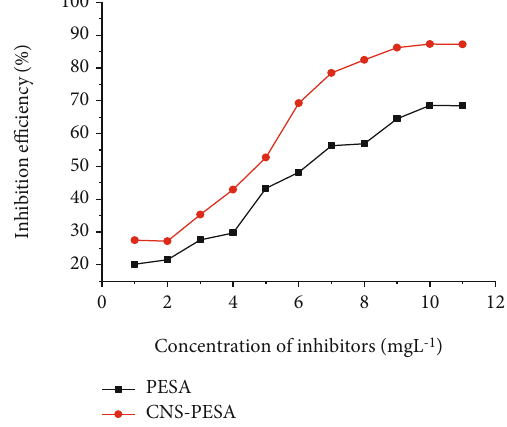
Figure 5: Calcium phosphate scale inhibition e ffi ciency of PESA and CNS-PESA.